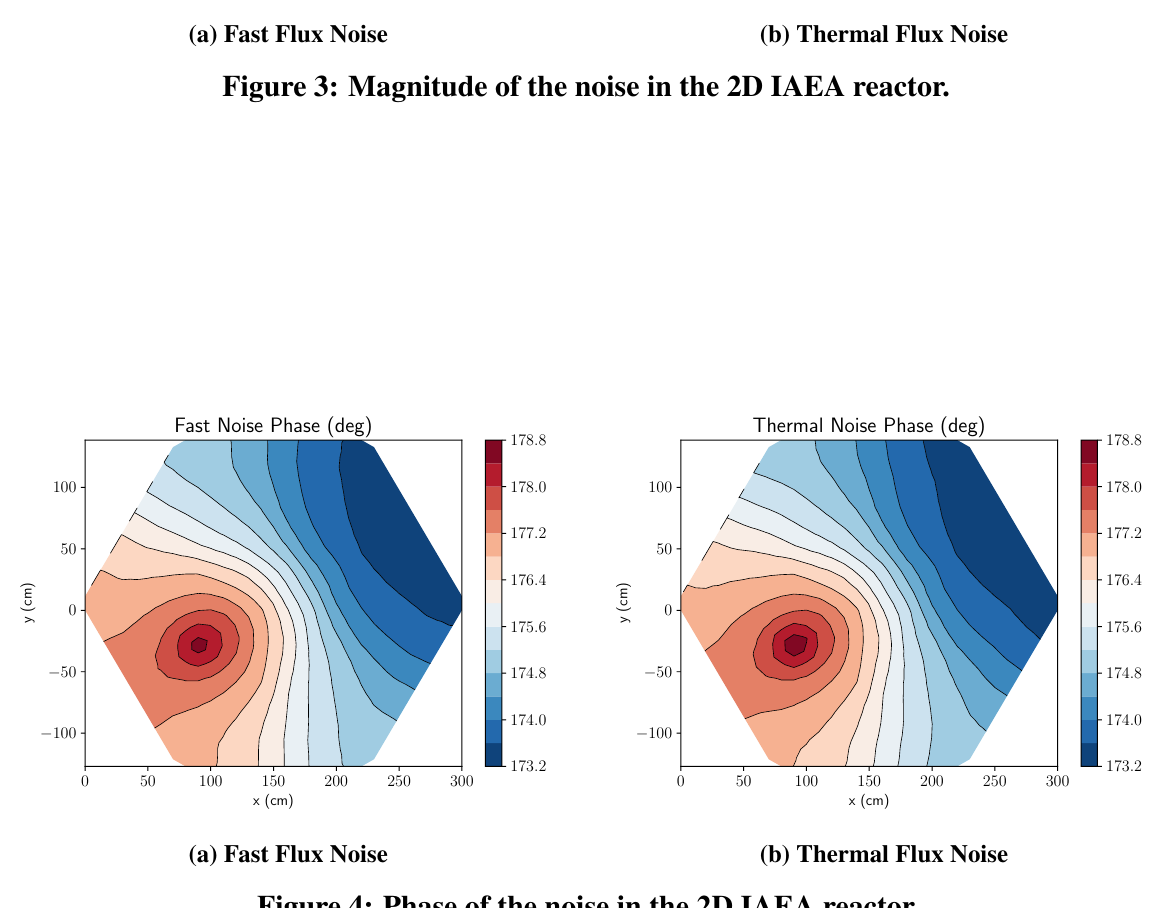
Figure 4: Phase of the noise in the 2D IAEA